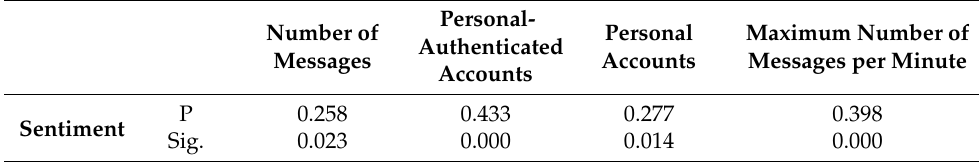
Table 3. Correlation coefficients between public sentiment and the number of messages, personal- authentication accounts, personal accounts, and maximum number of messages per